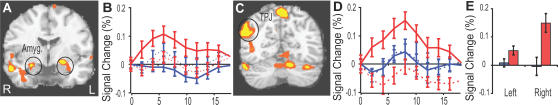
State by Group Interaction: A.(Amyg.) stands for amygdala (y = −5, color codes: orange, p<2.10ˆ-3, yellow, p<5.10ˆ-4). B. Impulse response in (Amyg.) for 15 experts (red) and for 15 novices (blue) during rest (dashed line) and compassion (full line). C–D. Same as A–B in TPJ; y = −61. E. Side by state effect and side by state by group effect in TPJ on the average impulse response between meditation and rest; experts are in red, novices in blue.